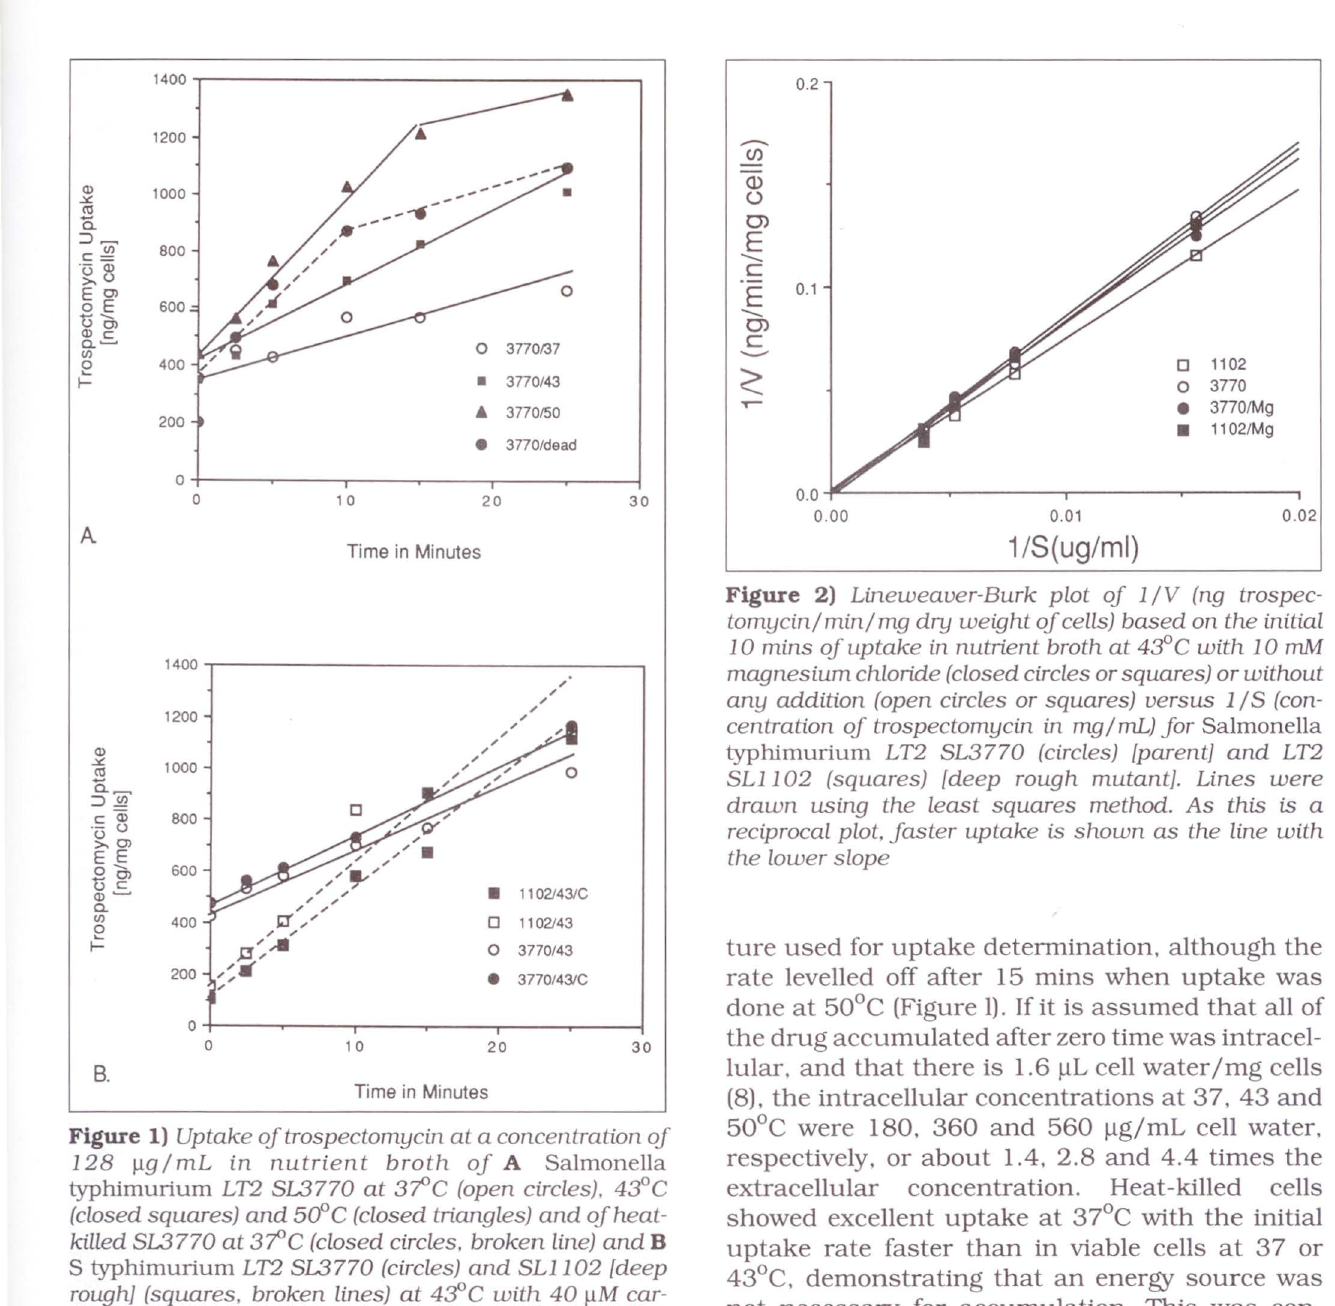
centrations gave a pattern of nonsaturability when the data were plotted by the Lineweaver Burk method (Figure 2). Other tested circumstan ces where uptake was also not saturable were with EcoliSA1306 at 43°C and HinfluenzaeRd at 37°C (data not shown). Comparison of uptake by smooth S